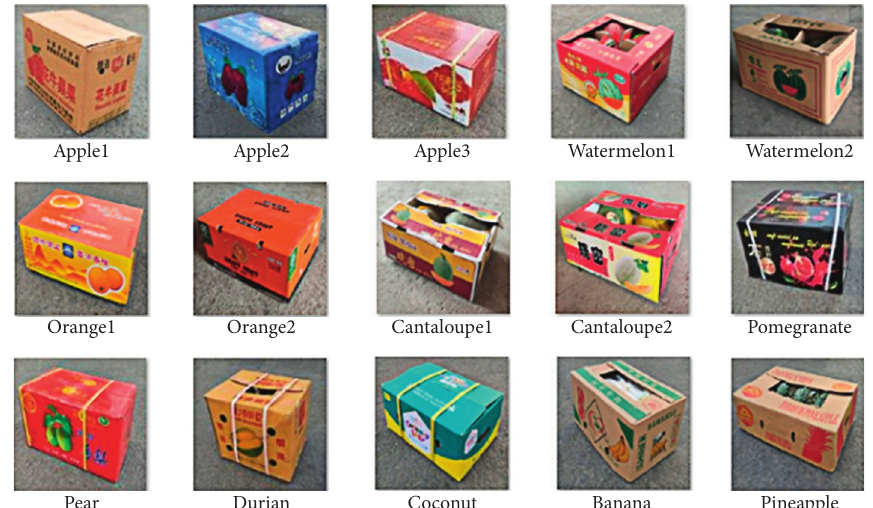
Figure 3: Categories of fruits boxes dataset.